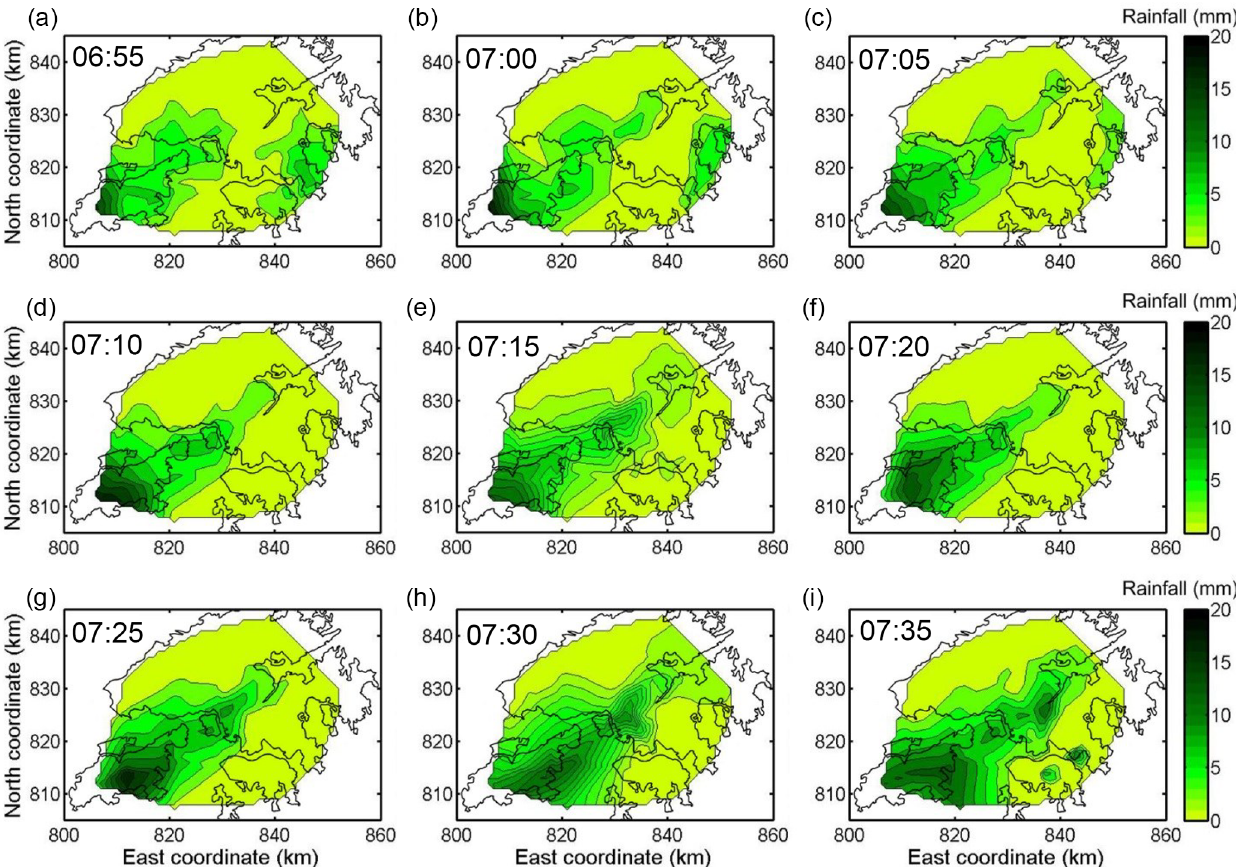
Figure 9. Instantaneous rainfall process from 06:55 to 07:35LT on 7 June